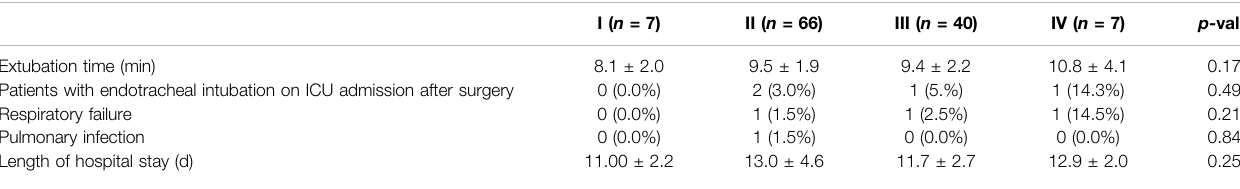
TABLE 4 | Postoperative pulmonary